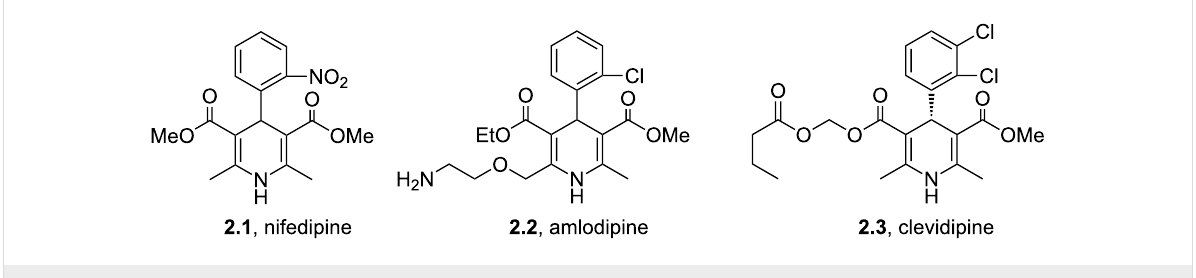
Figure 3: Structures of nifedipine, amlodipine and clevidipine.